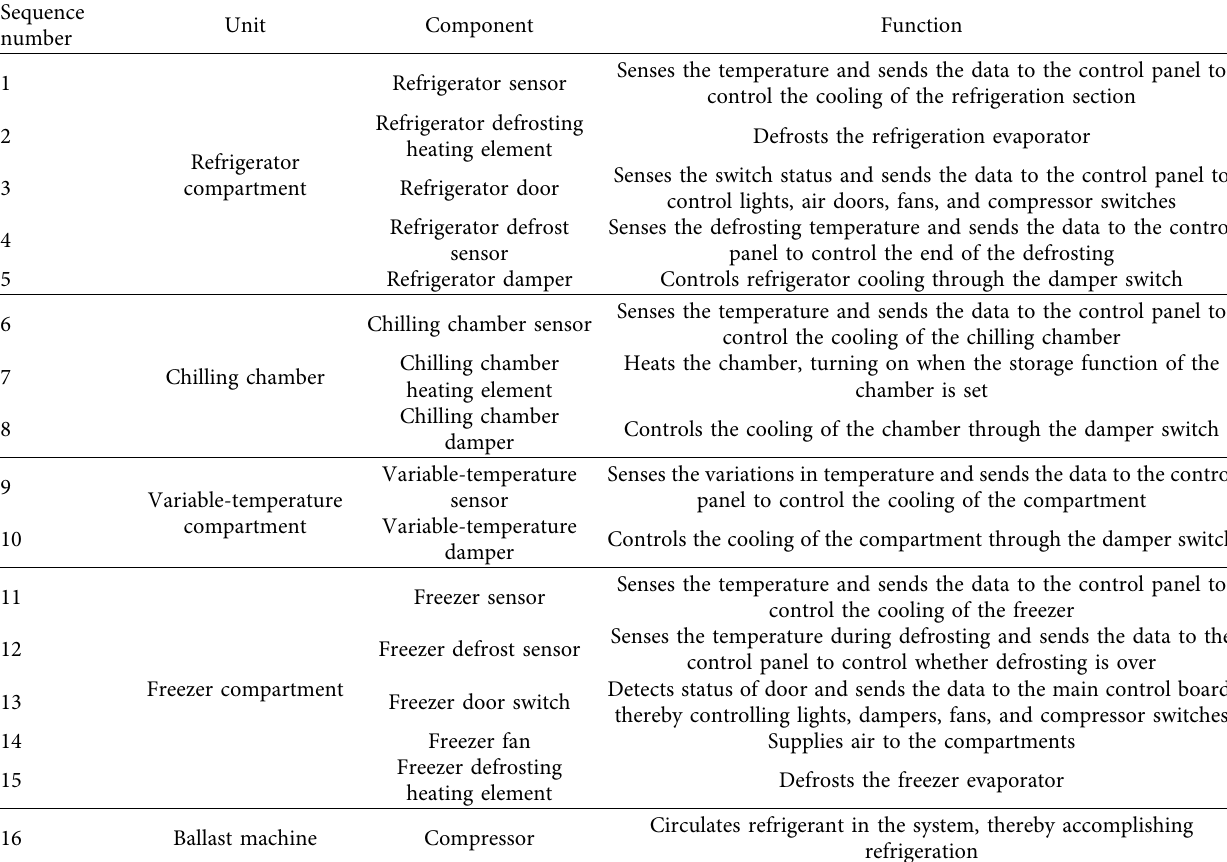
Table 1: Physical structure and function of the